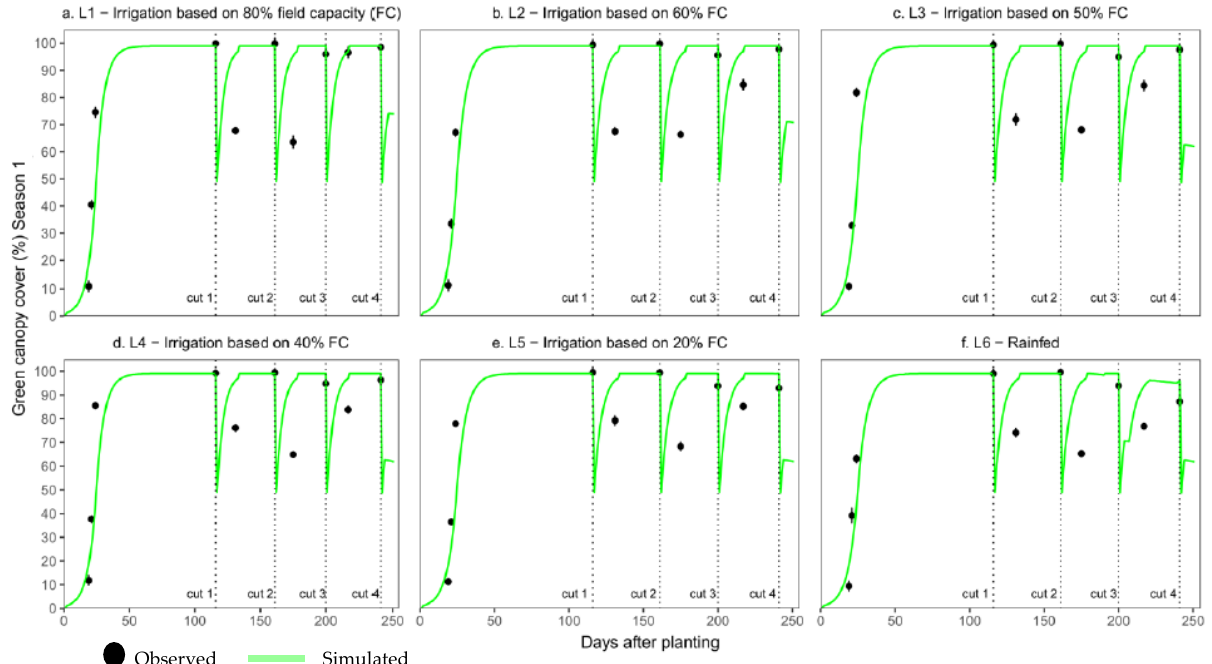
Figure 6. Observed and simulated canopy cover (CC) under different irrigation treatments during the first growing season (2020/21) of Guinea grass ( Megathyrsus maximus cv. Agrosavia sabanera). The error bars represent standard deviations. (a). CC for the treatment L1—irrigation based on 80% field capacity (FC); (b). CC for the treatment L2—irrigation based on 60% FC; (c) CC for the treatment L3—irrigation based on 50% FC; (d) CC for the treatment L4—irrigation based on 40% FC; (e) CC for the treatment L5—irrigation based on 20% FC; (f) CC for the treatment L6—rainfed.